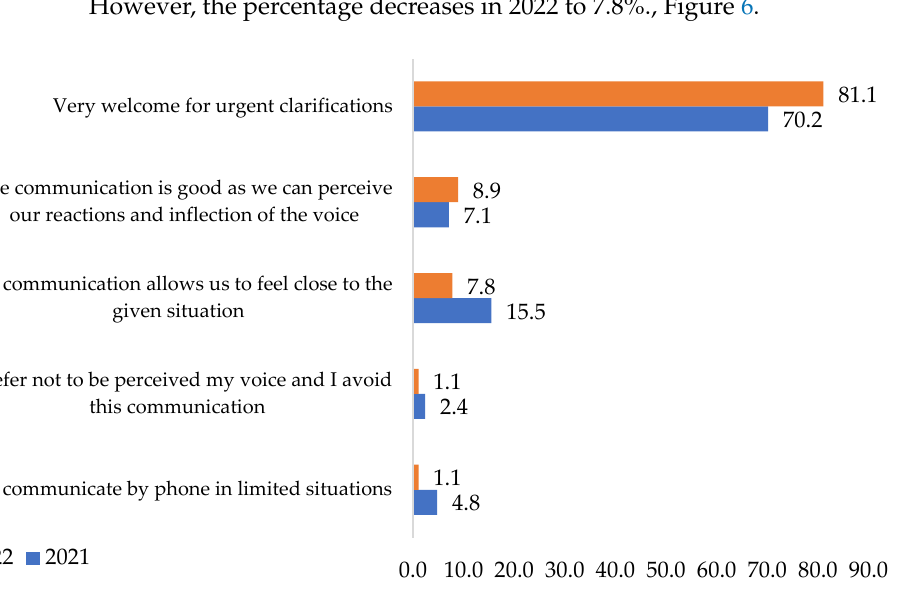
Figure 6. Telephone communication with co-workers. Source: Data from field quizzes, 2021, 2022.